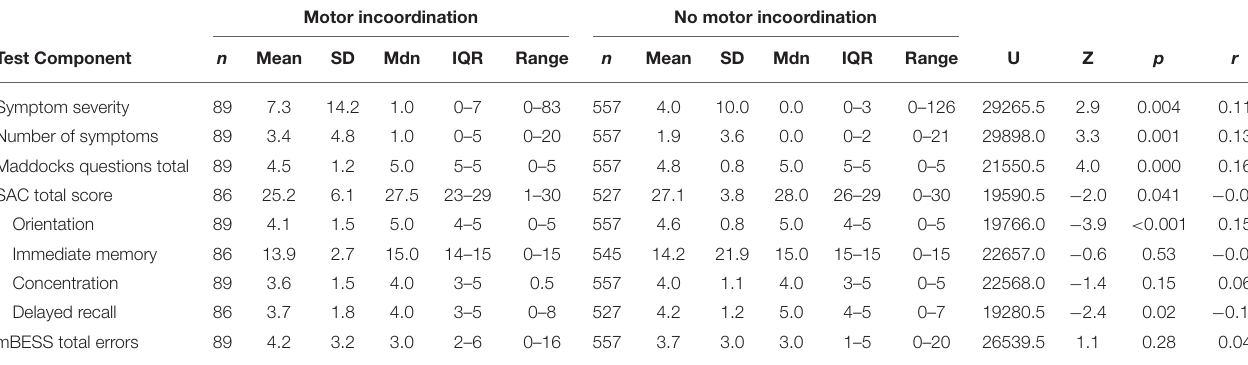
TABLE 1 | Full sample SCAT5 component scores by presence vs. absence of motor incoordination.